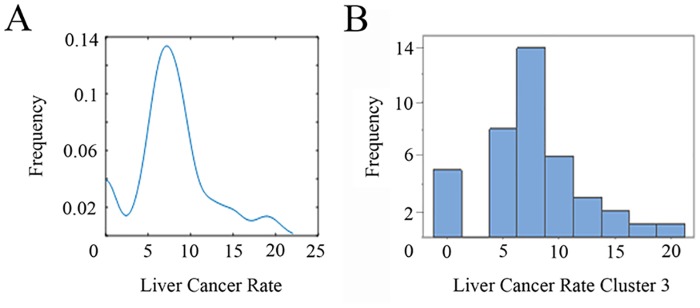
(A) Kernel estimator and (B) histogram for liver cancer rate in cluster 3.